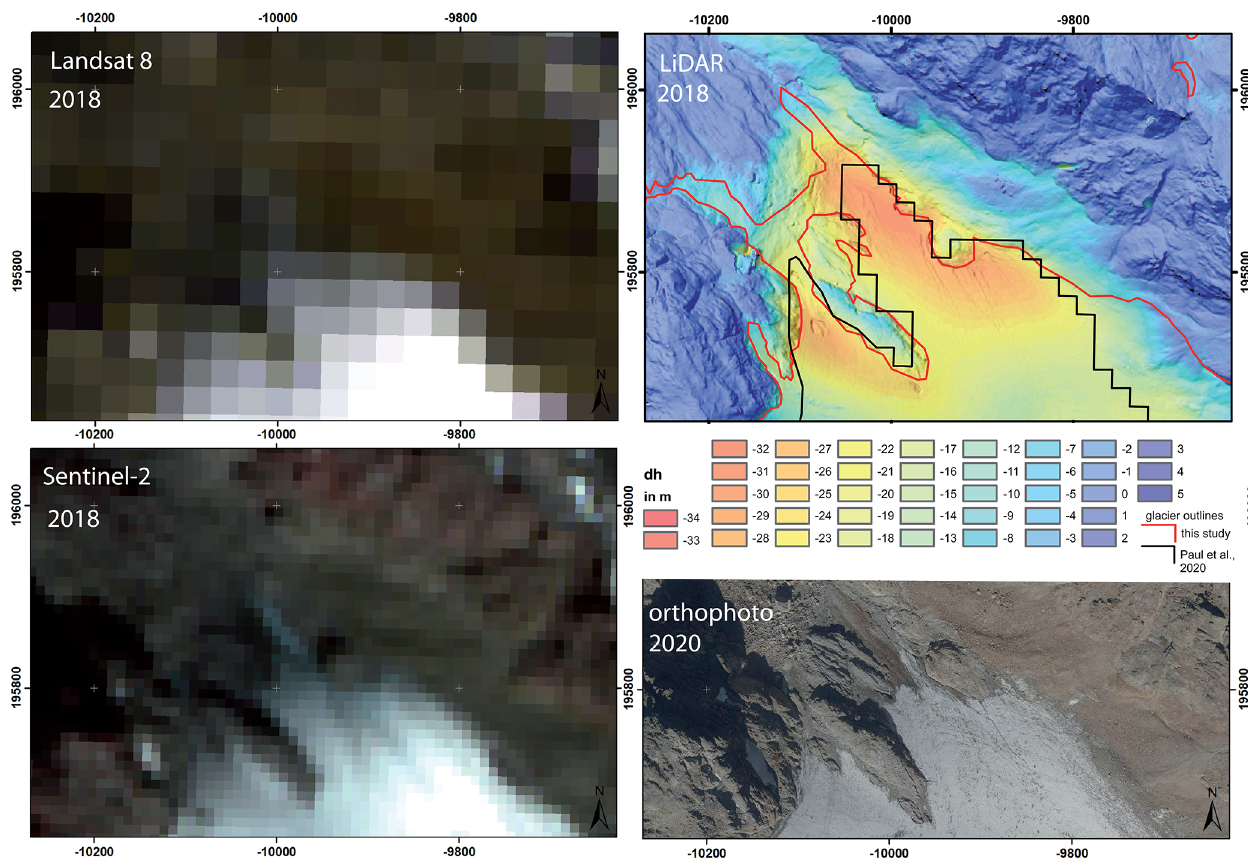
Figure 11. The comparison of the Landsat 8, Sentinel-2, and lidar images (hillshade and volume change 2006–2018, colour map like in Fig. 10), all dating from 2018, and the orthophoto (2020) illustrates the different representation of the glacier in the various spatial resolutions for the snout of Schnapfenkuchl M. For glaciers with bare ice, glacier margins are clear at all scales of